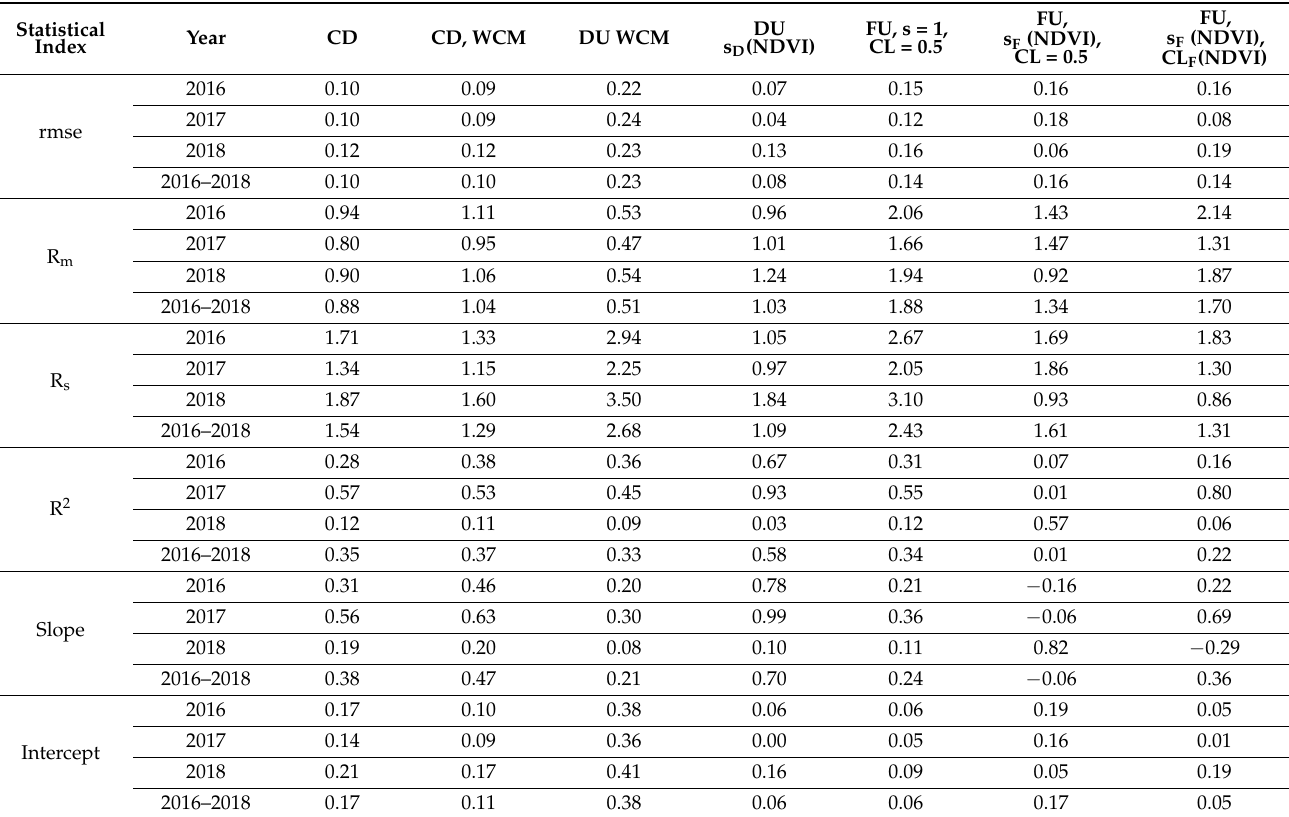
Table 1. Statistical index of method performance for soil moisture estimation from Sentinel 1 observations at the Sardinian site [CD, change detection method; CD, WCM, change detection method using the water cloud model; DU WCM, DU method using the Water Cloud Model; DU σ D (NDVI), DU method using the proposed σ D (NDVI) relationship; FU, σ = 1, CL = 0.5, FU method using constant σ and CL ; FU, σ F (NDVI), CL = 0.5, FU method using constant CL and the proposed σ F (NDVI) relationship; FU, σ F (NDVI), CL(NDVI), FU method using the proposed σ F (NDVI) and CL F (NDVI) relationships; rmse, root mean square error; R µ , mean ratio; R σ , standard deviation ratio; slope and intercept of the regression line between soil moisture field observations and soil moisture